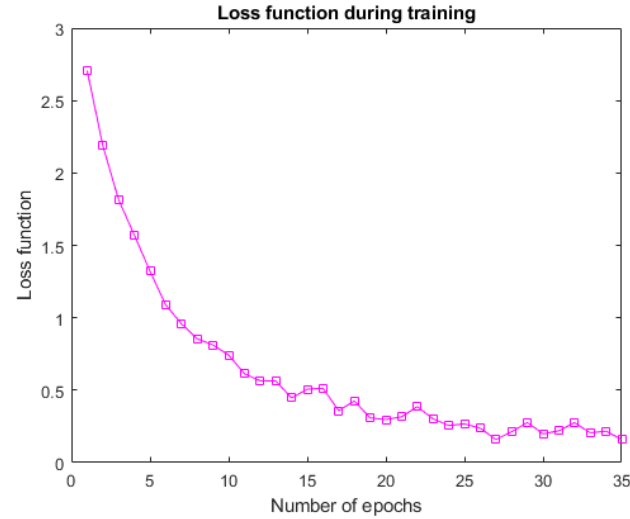
Figure 9. Accuracy during training process.